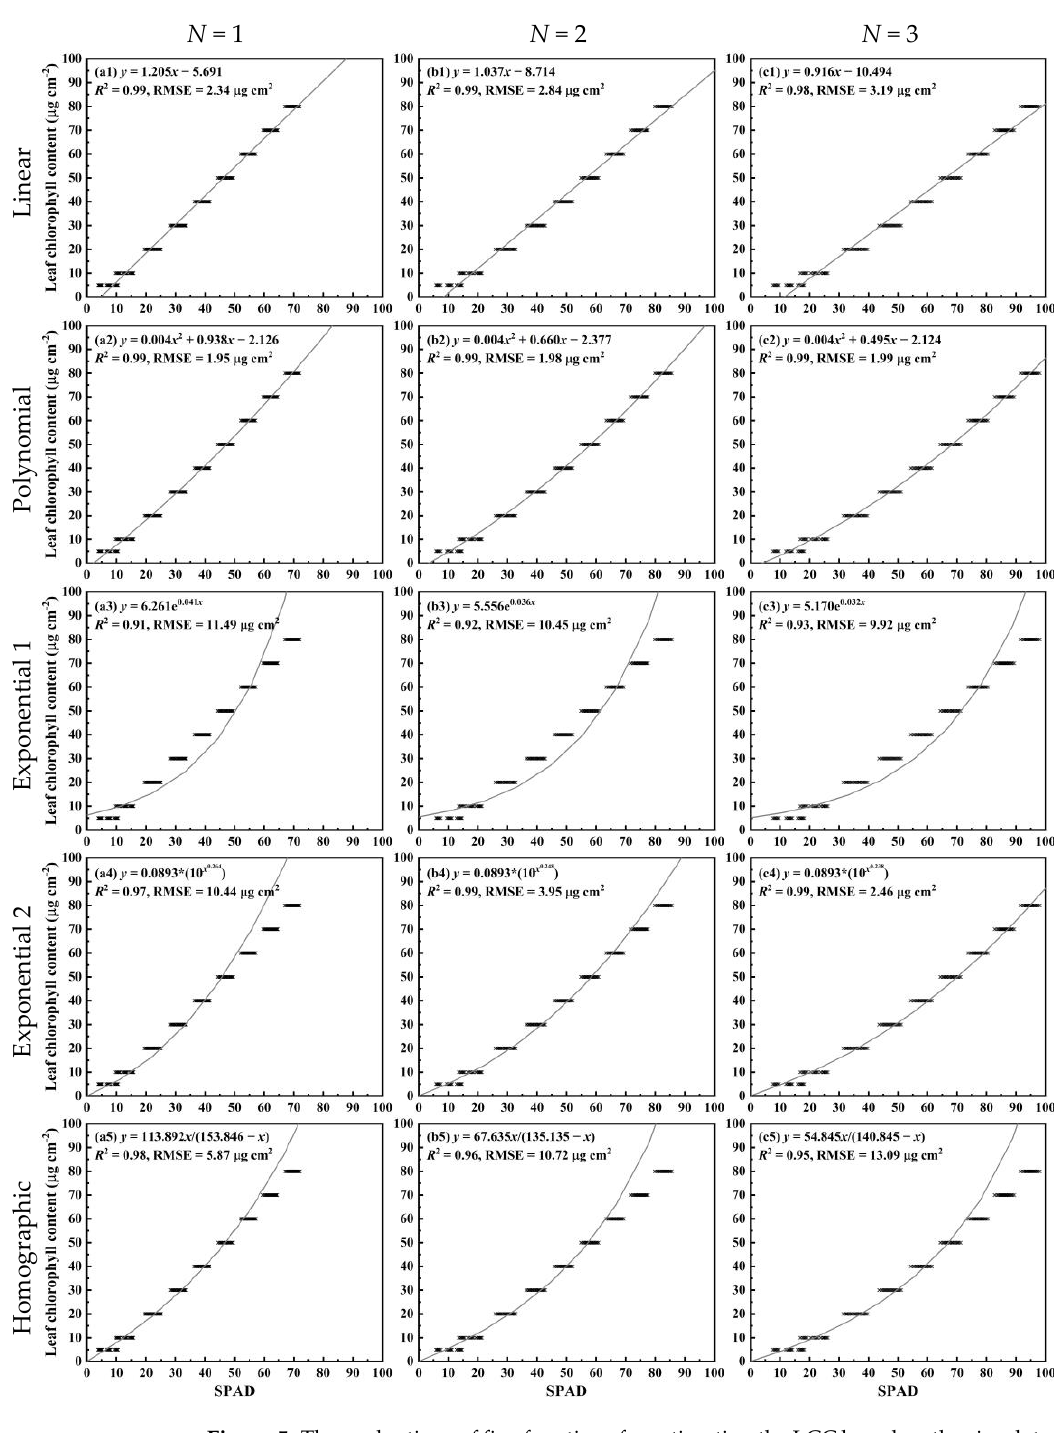
Figure 5. The evaluations of five functions for estimating the LCC based on the simulated dataset from the PROSPECT-5 model. The left, middle, and right panels represent model evaluations for N = 1, N = 2, and N = 3, respectively. Exponential 1 is the exponential function LCC = 𝑎 ∗ 𝑒 𝑏∗SPAD , and Exponential 2 is the exponential function LCC = 0.0893 ∗ (10 SPAD 𝛼 ) . N is the leaf structure parameter.